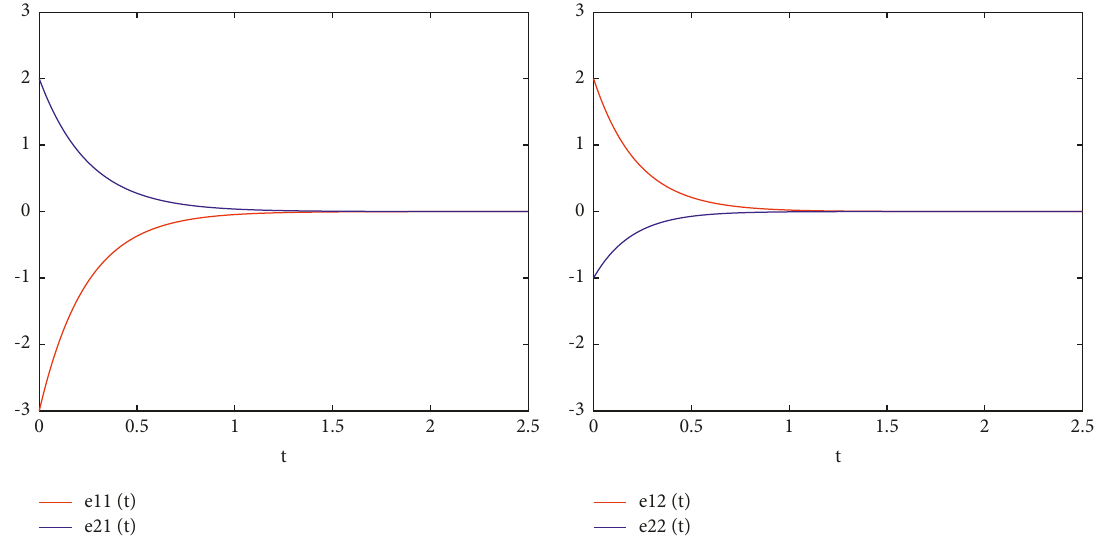
Figure 5: The evolvement behavior of error system (86) under a nonlinear control law.